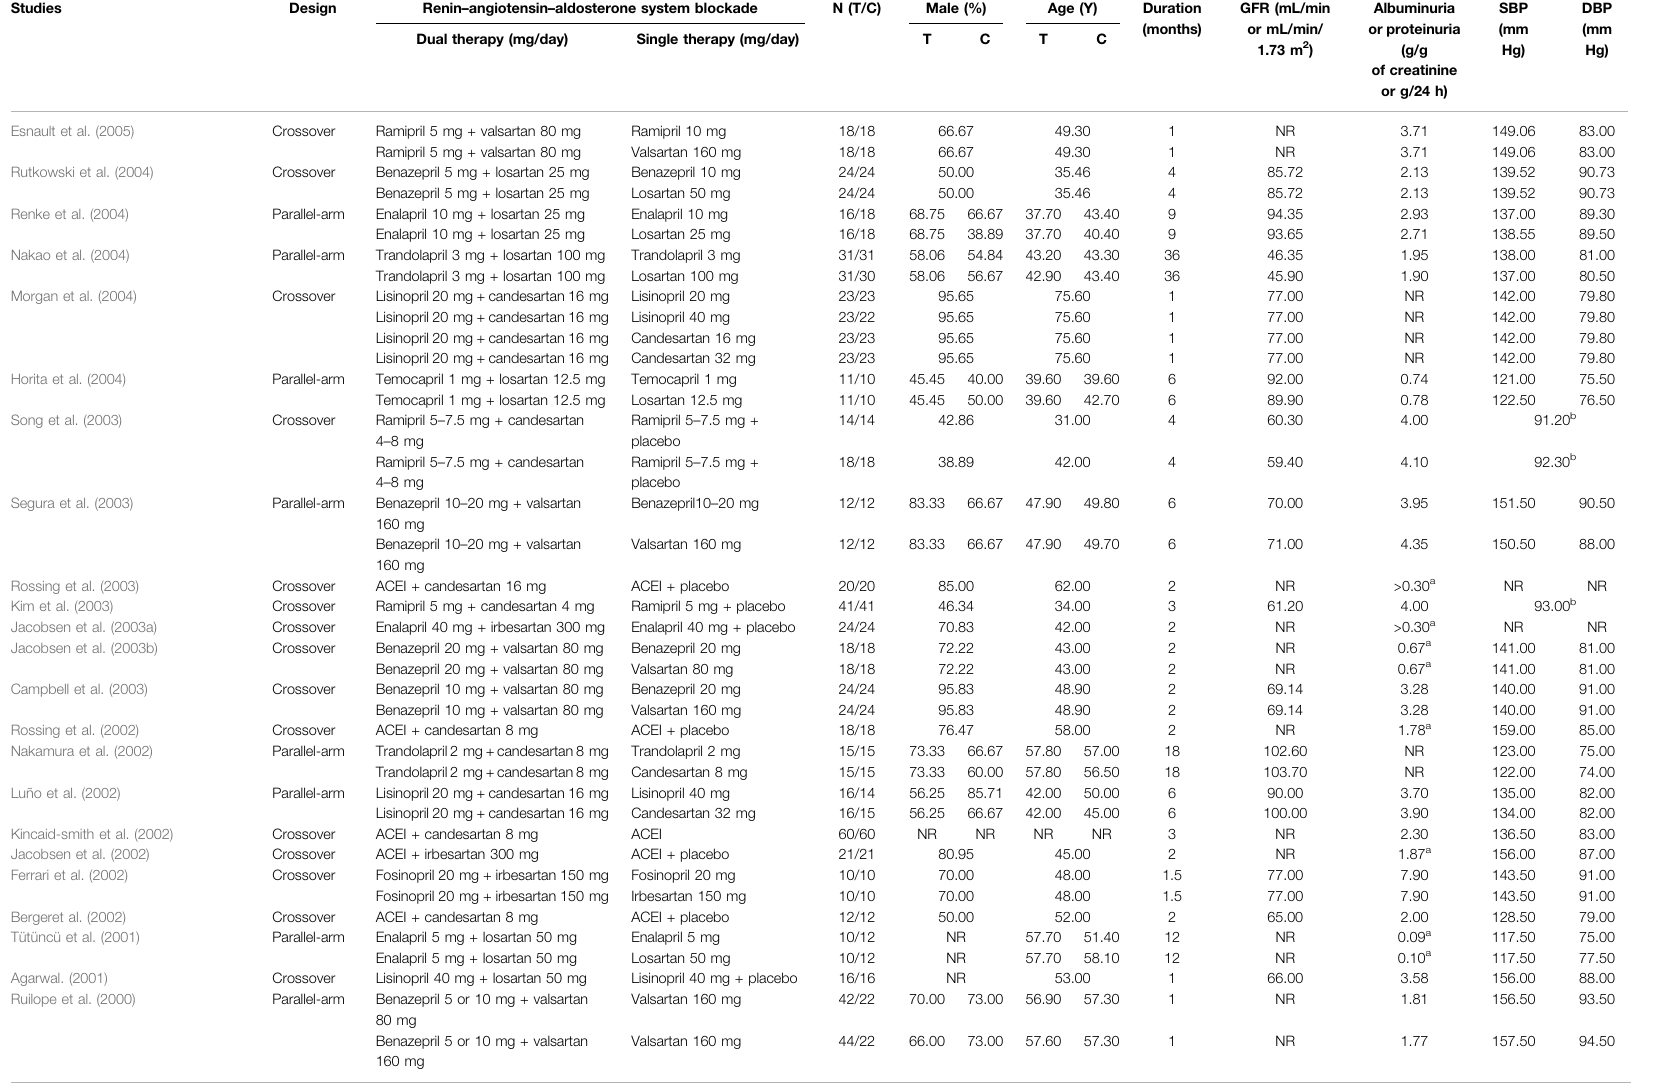
Abbreviations: N,Numberofpatients;T,treatmentgroup;C,controlgroup;Y,year;sCr,serumcreatinine;GFR,glomerular fi ltrationrate;SBP,systolicbloodpressure;DBP,diastolicbloodpressure;ACEI,angiotensin-convertingenzyme inhibitor; ARB, angiotensin-receptor blocker; NR, not reported. a Value represents urinary albumin excretion. b Mean arterial